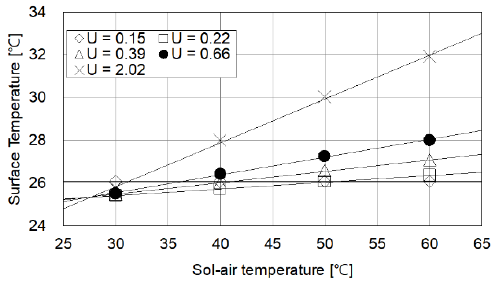
Figure 8. Sol-air temperature and surface temperature for the heat transmission coefficient of the wall.